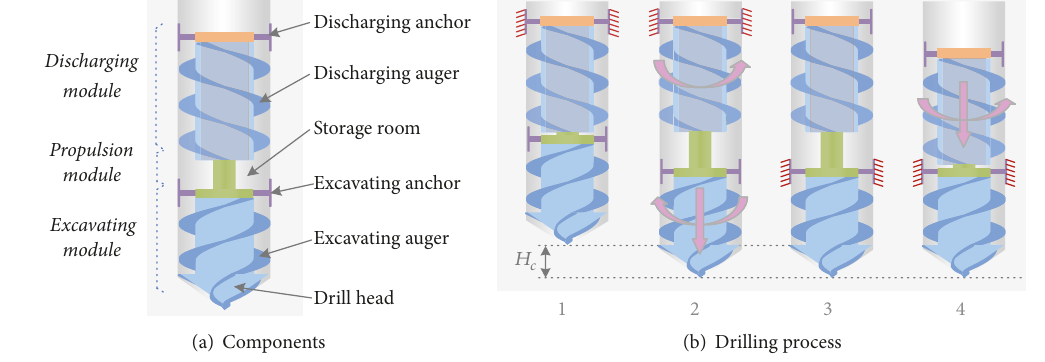
Figure 2: Components and drilling process of IBR.